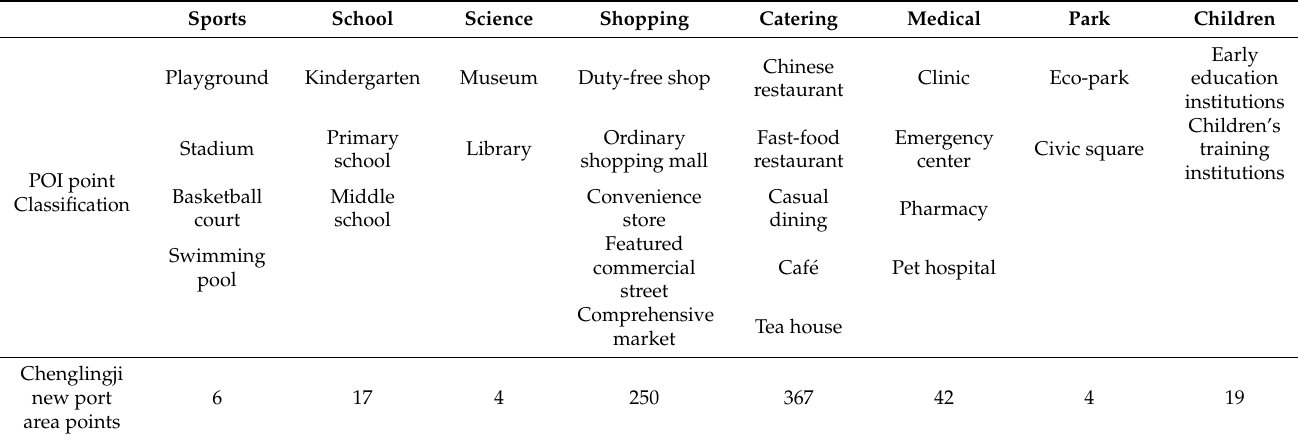
Table 4. Classification and quantity of POI points for public service facilities in the Chenglingji new port